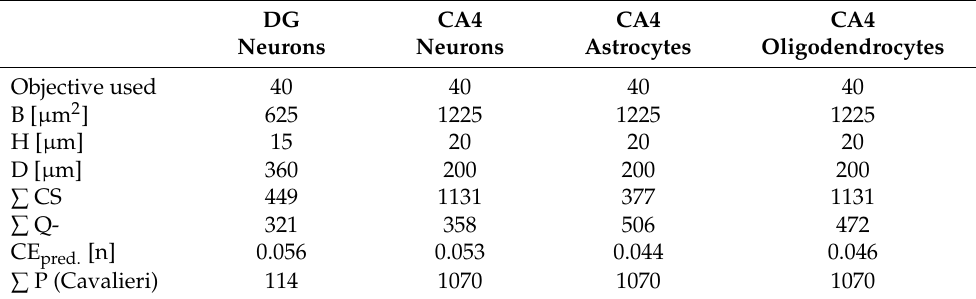
Table 2. Details of the stereological counting